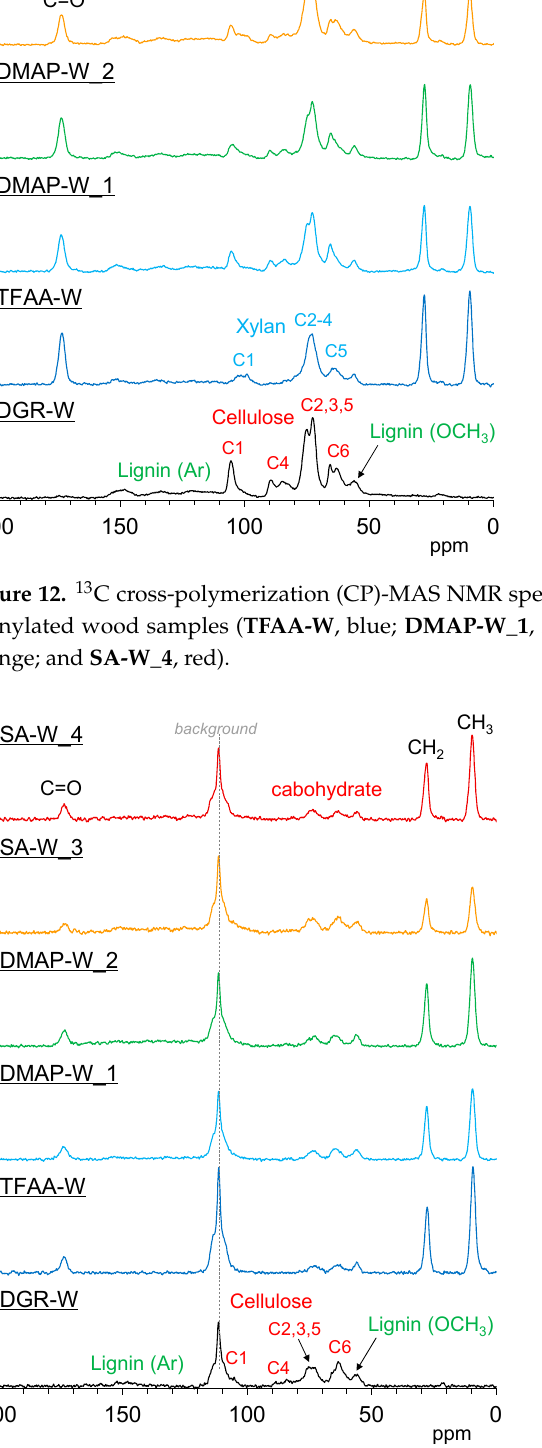
Figure 13. 13 C pulse saturation transfer (PST)-MAS NMR spectra of degreased wood (black) and propionylated wood samples ( TFAA-W , blue; DMAP-W_1 , light blue; DMAP-W_2 , green; SA-W_3 , orange; and SA-W_4 , red).